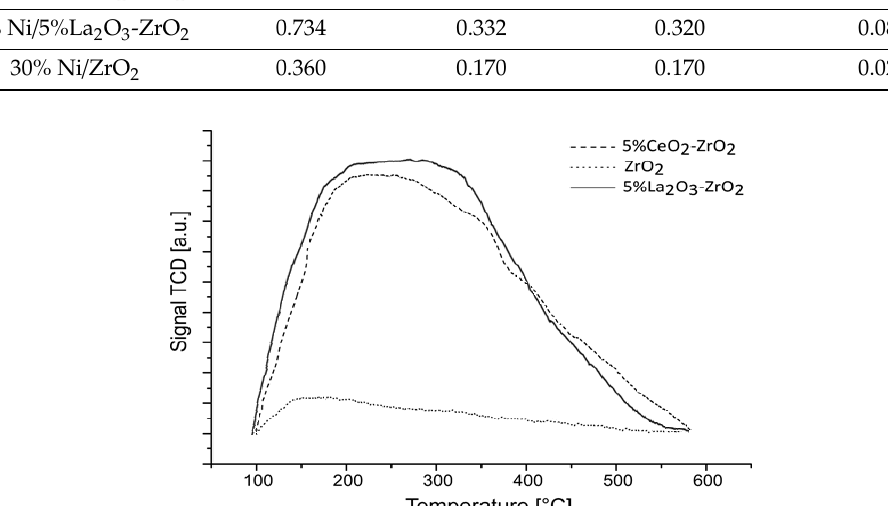
Figure 16. TPD-NH 3 profile of ZrO 2 , 5%CeO 2 -ZrO 2 , and 5%La 2 O 3 -ZrO 2 carriers calcined in an air atmosphere for 4h at 400 °C.